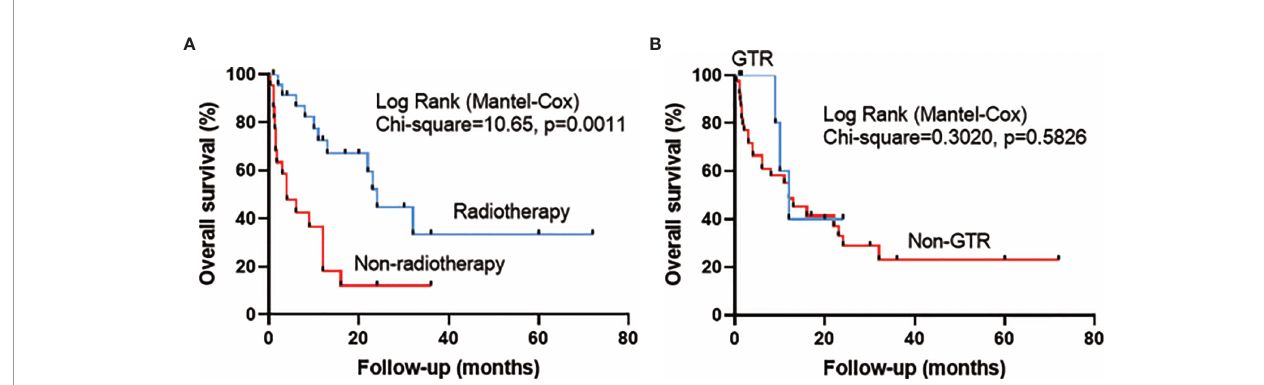
FIGURE 1 | Survival curve analysis (log-rank test) illustrating the different overall survival (OS) rates in pooled cases between (A) radiotherapy and no radiotherapy and between (B) gross total resection (GTR) and non-gross total